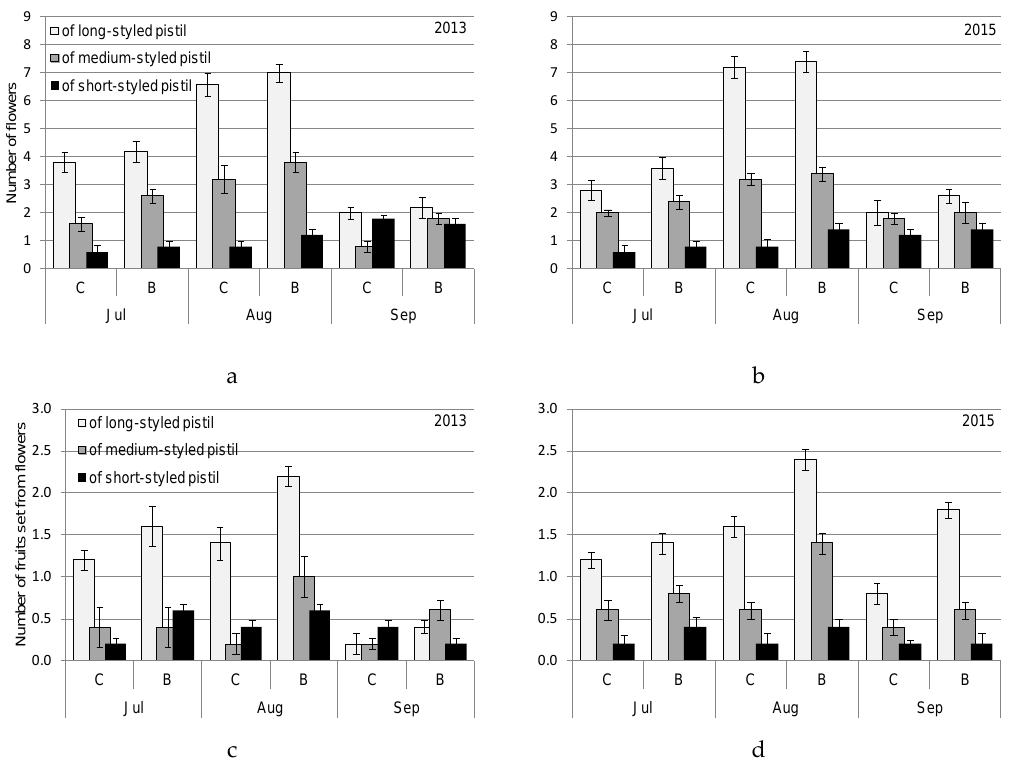
Figure 4. The course of flowering and fruit setting of “Epic” F 1 eggplant as depended on fruit type and biostimulant treatment. C, control; B, biostimulant. Bars represent mean number of flowers per plant in 2013 ( a ), 2015 ( b ) and fruits per plant in 2013 ( c ), and 2015 ( d ) (error bars indicate